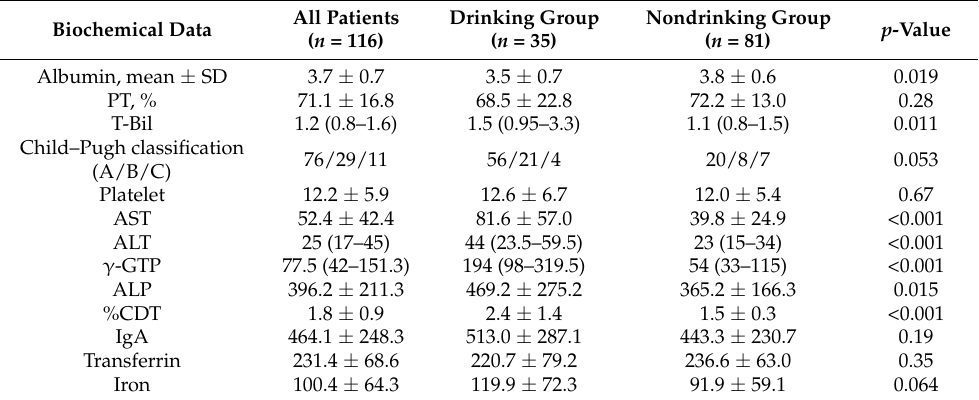
Table 2. Comparison of biochemical data on alcoholic cirrhosis between the drinking and nondrinking groups.